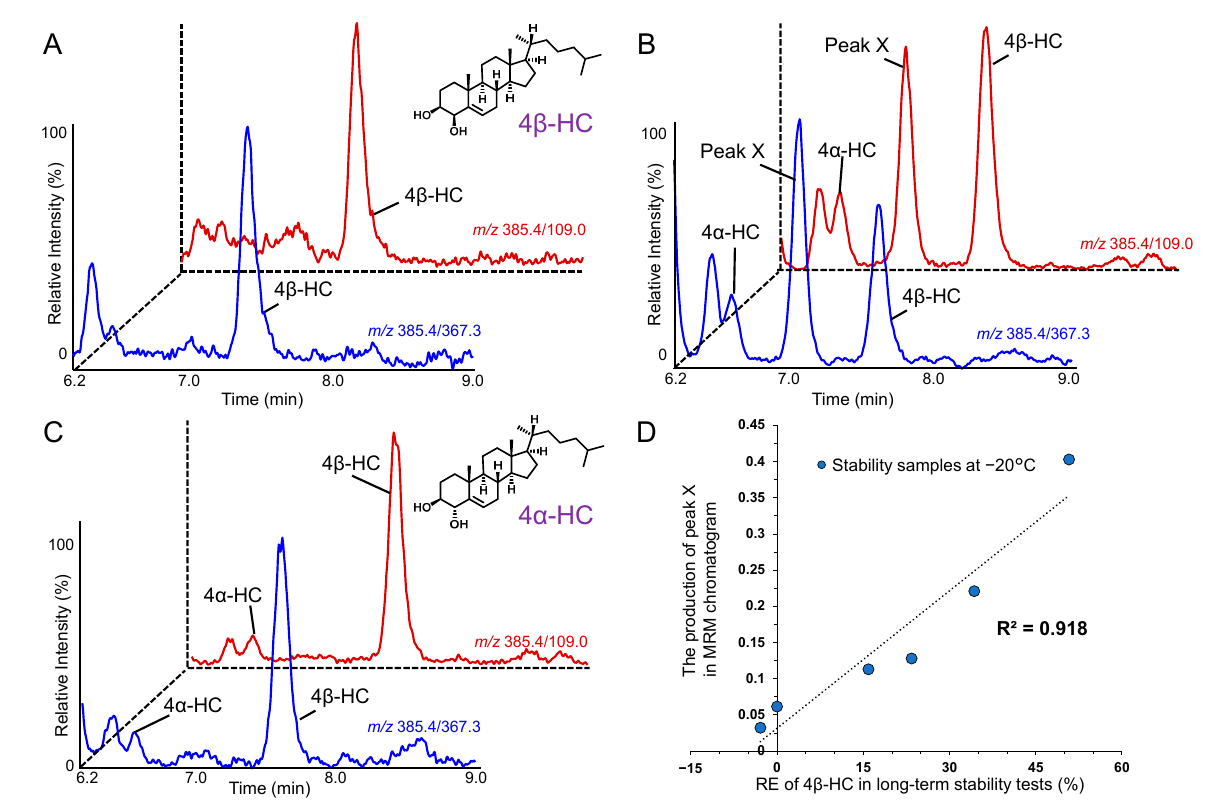
00.050.10.150.20.250.30.350.40.45 R² = 0.918 Figure 1. Typical MRM chromatograms analyzing plasma that was obtained with K2-EDTA, then analyzed without storage ( A ), or analyzed after 13 months of storage in the dark at − 20 °C ( B ) or − 80 °C ( C ). Each plasma sample was saponified, extracted with hexane, and analyzed with LC-MS/MS in the MRM mode. Extended MRM chromatograms between the retention times of 6.2–9.0 min are shown. Other details are described in the Methods section. Identification of 4 β -HC and 4 α -HC was performed by comparing the two markers against commercial standards. The correlation chart between the production of peak X and the relative error (RE) of 4 β -HC in the plasma was analyzed during the long-term storage test ( D ). Peak X was corrected in accordance with the internal standard 4 β -HC-d7 (i.e., the ratio of the area of peak X to the area of 4 β -HC-d7 was calculated). A correlation diagram was created by plotting the peak area ratio of peak X and 4 β -HC-d7 after long-term storage at − 20 °C on the Y-axis and the RE shown in Table 1B on the X-axis ( D ). To correctly evaluate the relationships between CYP3A4 inducers and plasma 4 β